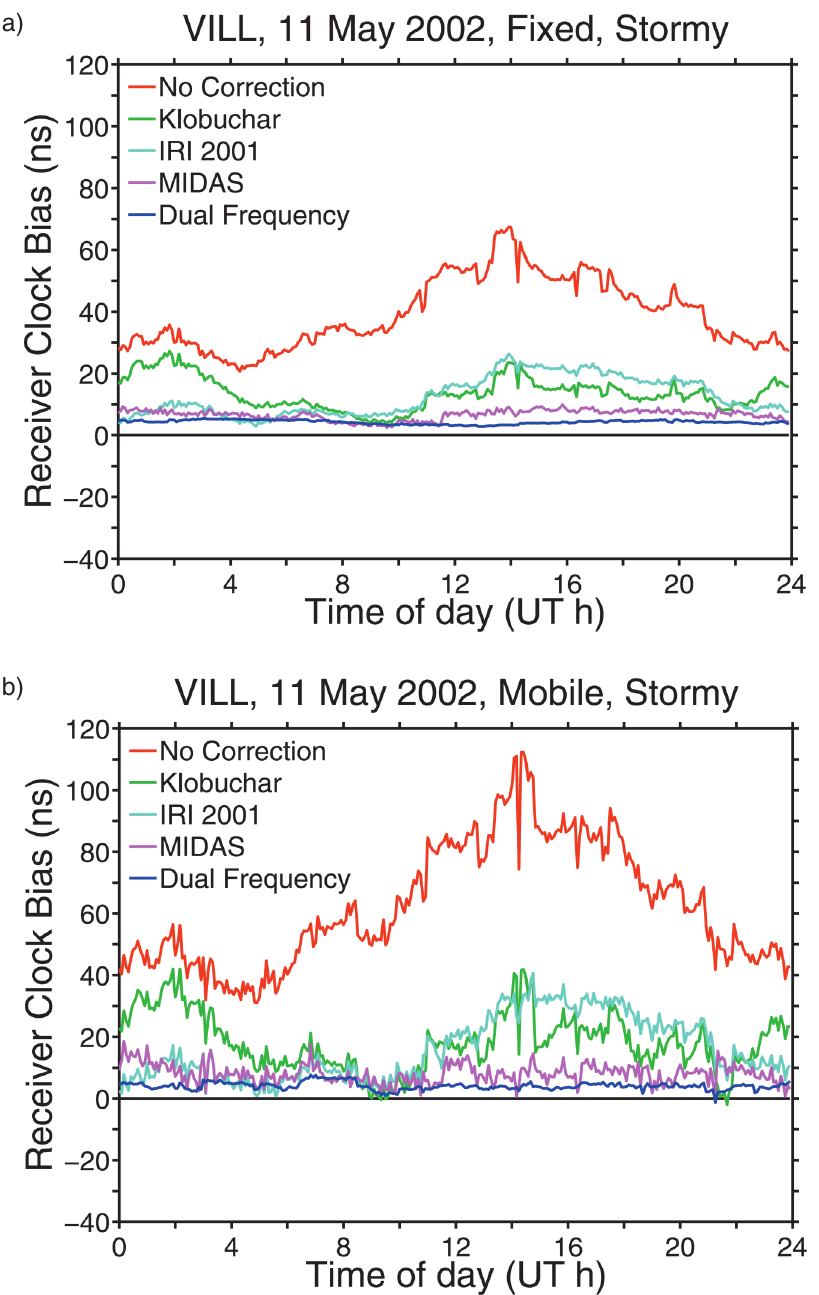
Fig. 5a,b. Receiver clock bias referenced to the receiver clock bias from CODE for VILL 11 May 2002, for a stormy ionosphere (Kp index 0.7-6.7) using a fixed (a) and mobile (b) GPS receiver